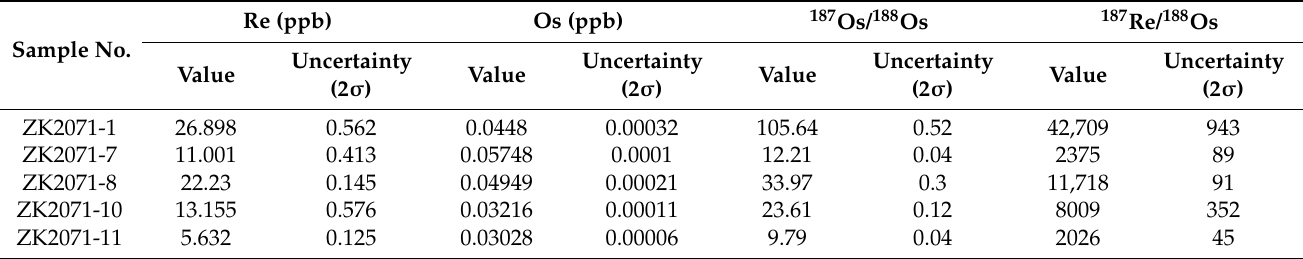
Table 7. Re-Os isotopic analysis of pyrite in the Shuikoushan deposit. Sample No.